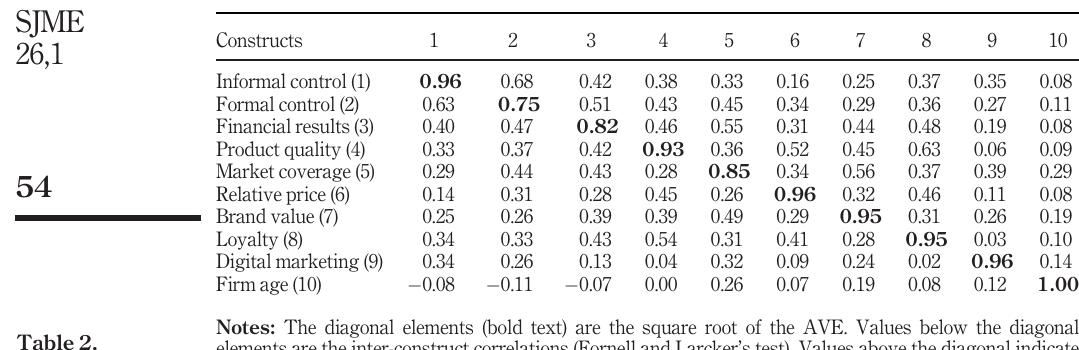
Table 2. Discriminant validity